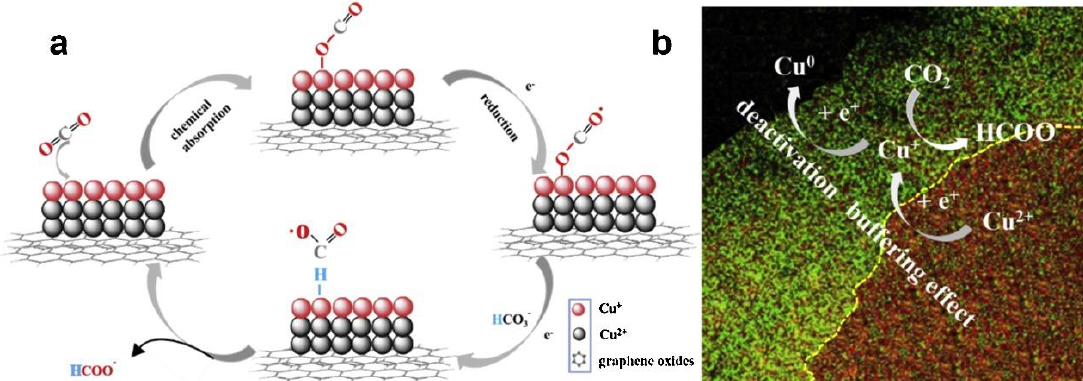
Figure 6. ( a ) A proposed mechanism illustrating the steps of electrochemical CO 2 reduction and the formation of HCOOH occurring at the G-Cu x O-2 h electrocatalyst. ( b ) A proposed “buffering effect” illustrating the origin of the durability of G-Cu x O-T electrocatalysts. Reprinted from Ref. [111], copyright (2019), with permission from Elsevier.